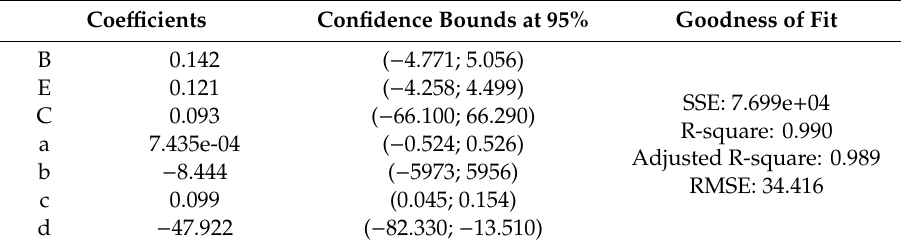
Table 2. Parameters for empirical model of lateral force fitting and goodness of